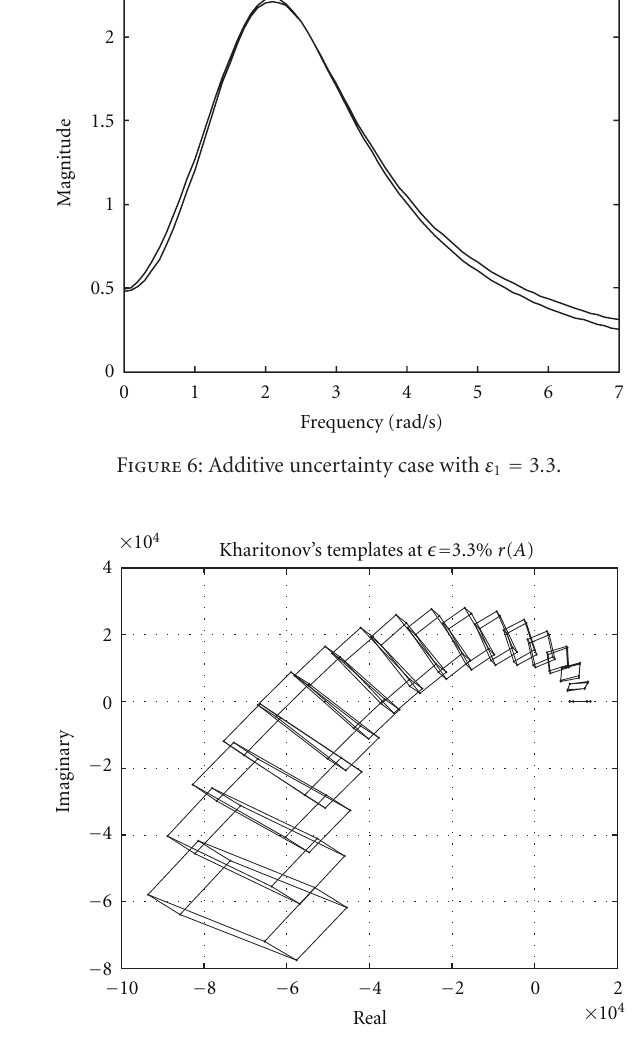
Figure 5: Step response of the stabilized interval system.